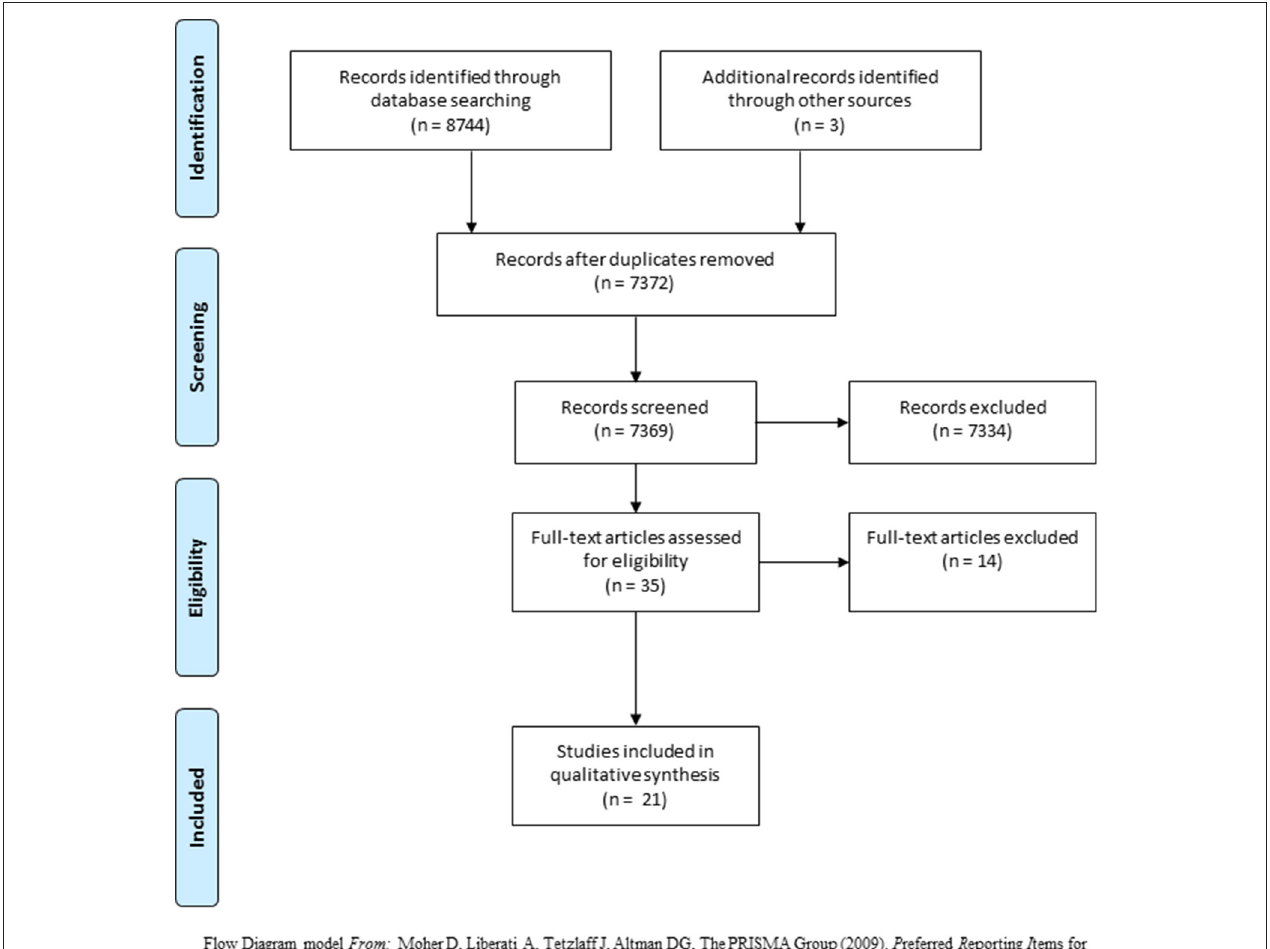
FIGURE 1 | Flowchart for literature